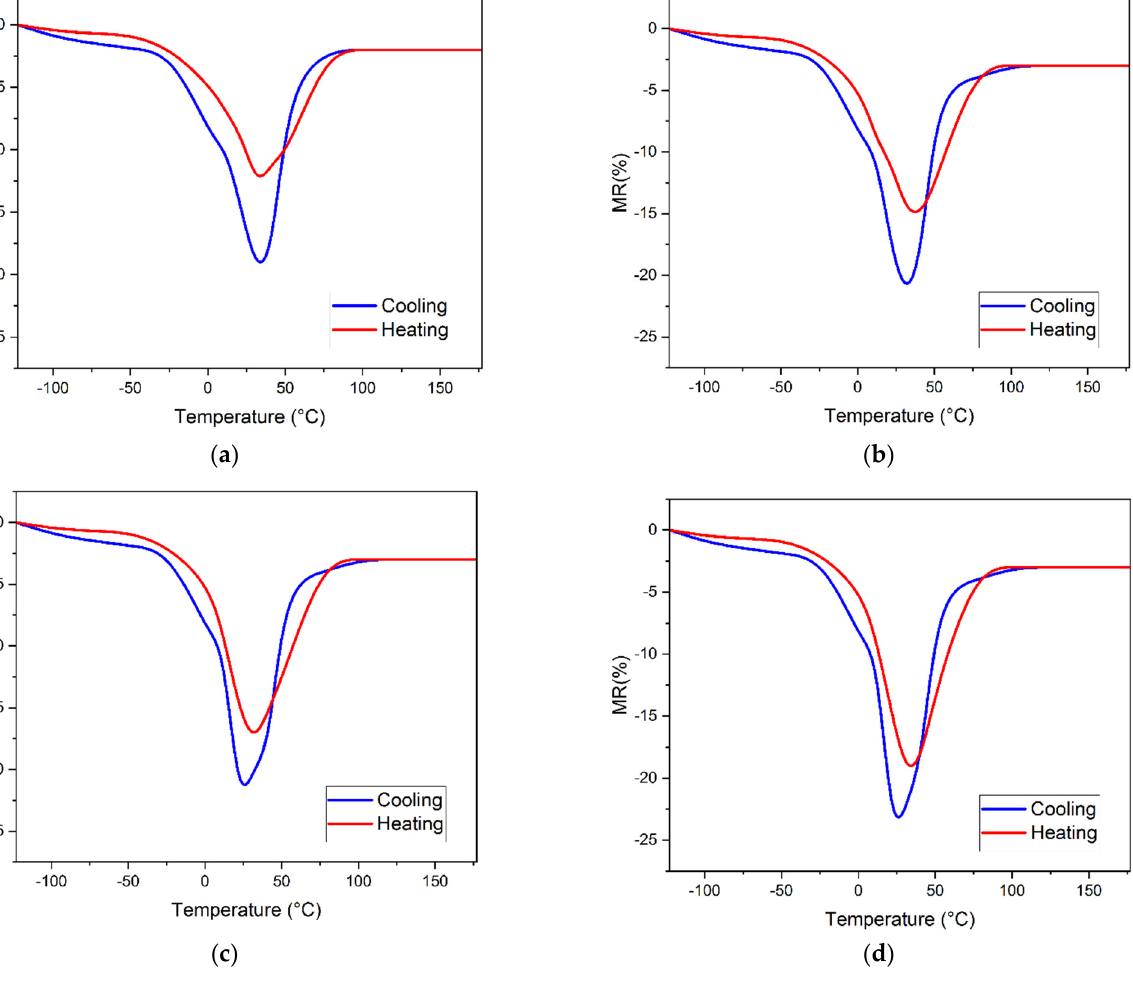
Figure 6. Negative magnetoresistance at the 5 T applied field for Ni 50 − x Fe x Mn 30 Sn 20 − y In y , where 1 ≤ x ≤ 4; 2 ≤ y ≤ 8 alloy and ( a ) x =1, ( b ) x = 2, ( c ) x = 3, and ( d ) x = 4.